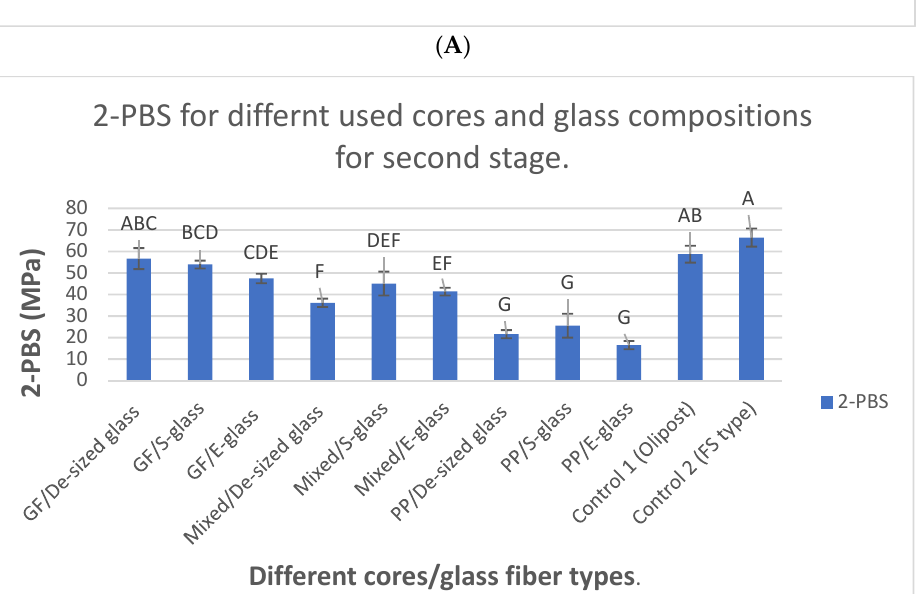
Table 3. Means and standard deviations (SD) of two-point bending flexural strength (2-PBS) (MPa) for first stage. Post Sheath Composition (PP/GF%)